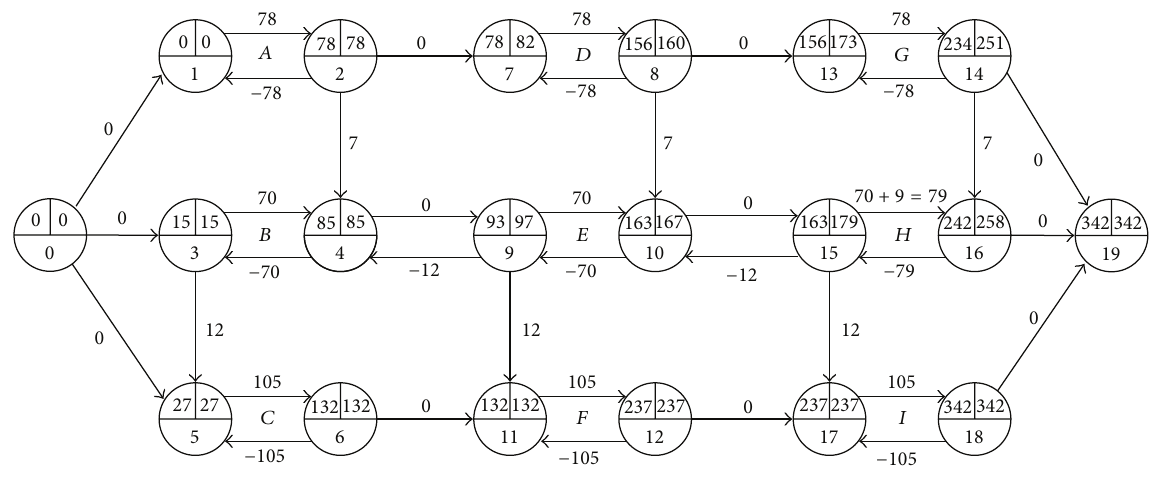
Figure 2: Network with duration prolongation 9 of the activity 𝐻